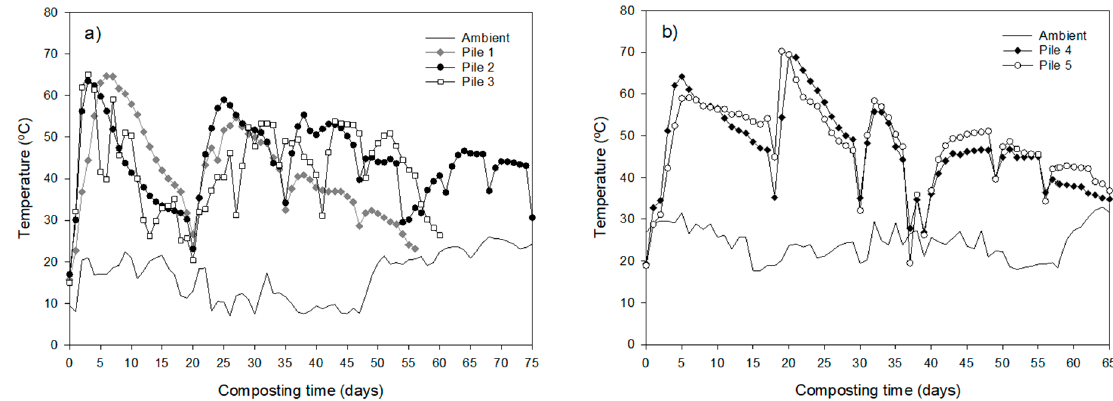
Figure 1. ( a ) Temperature evolution of the composting piles from Experiment 1 (Piles 1, 2, and 3, only constituting green wastes); ( b ) temperature evolution of the composting piles from Experiment 2 (Piles 4 and 5, constituting green wastes and sewage sludge).